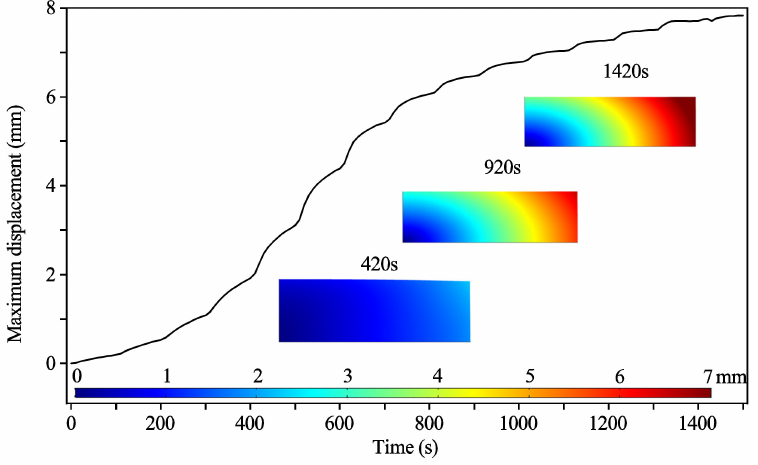
Figure 11. The von Mises